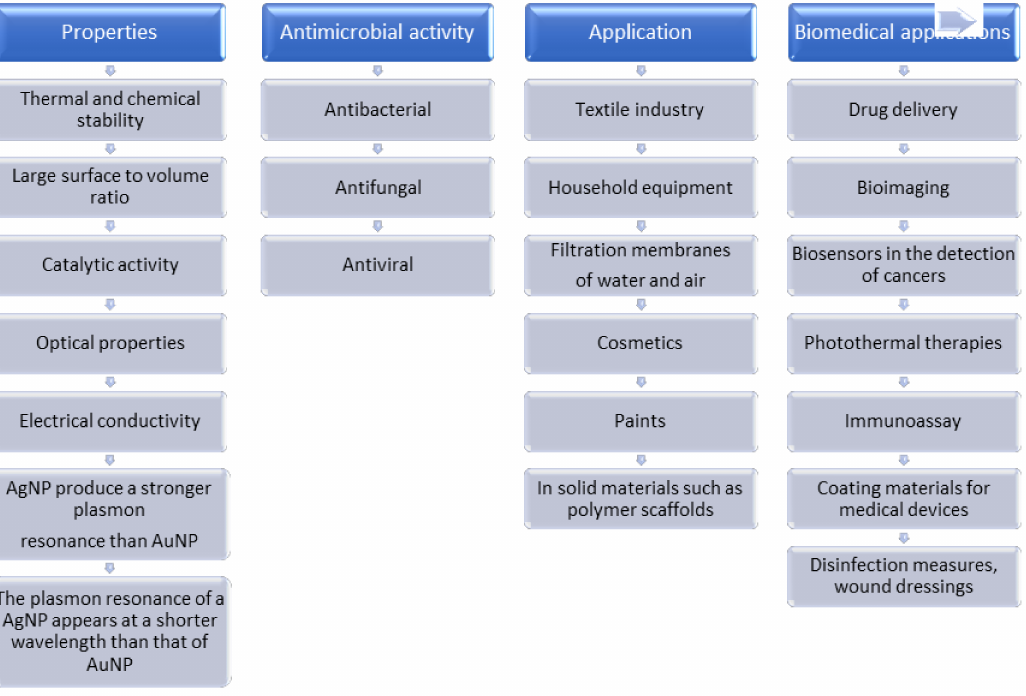
Figure 3. Main properties and applications of silver and gold